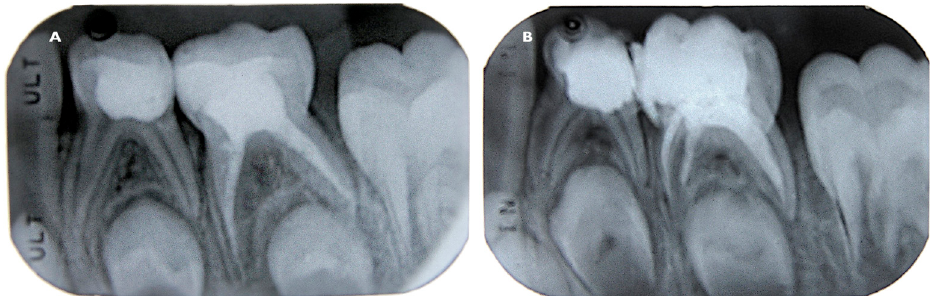
Figure 1. Postoperative radiographs of two mandibular second primary molars after endodontic treatment and coronal restoration ( A , B ).